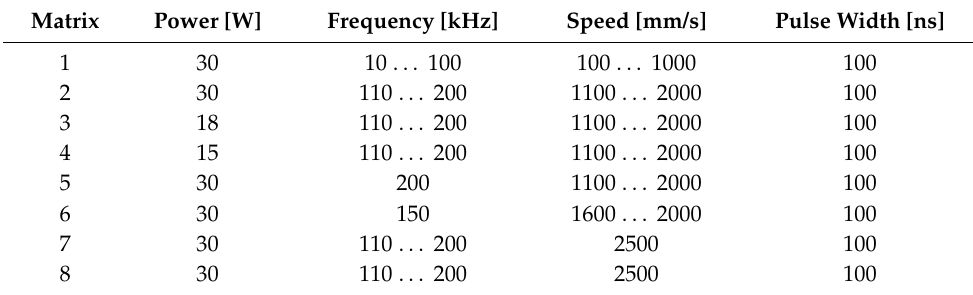
Table 2. Experimental data for the model constructions (resulting surfaces of matrix 3 is shown in Figure